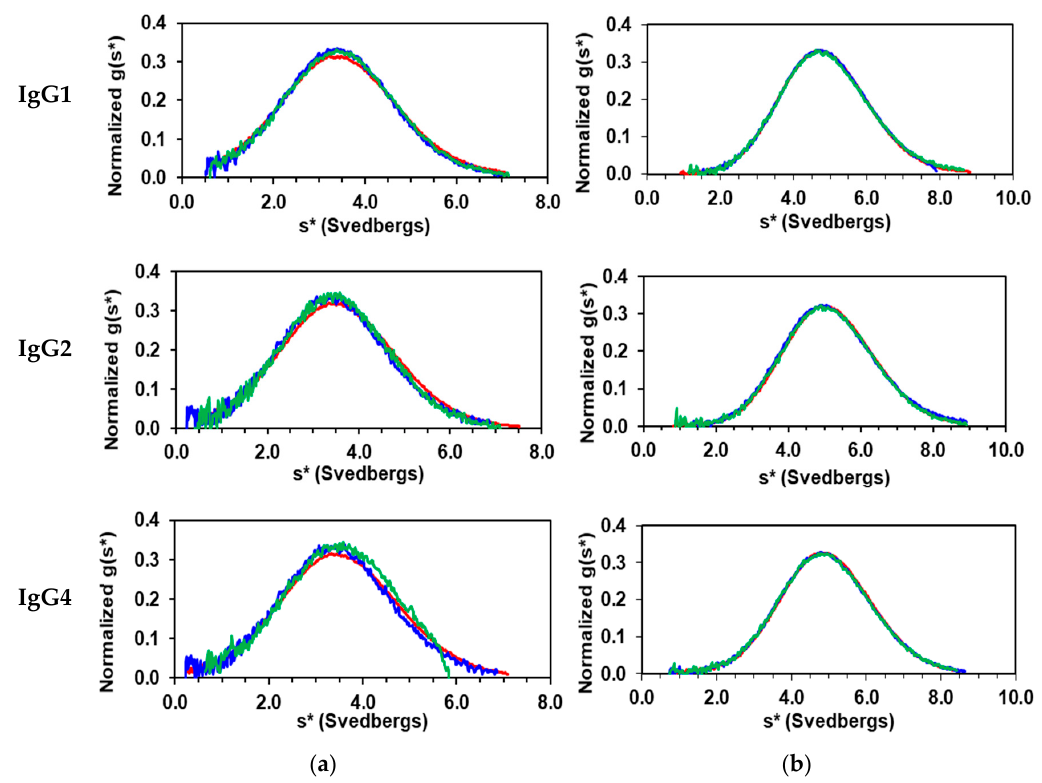
Figure 2. Sedimentation velocity analysis of IgG1, IgG2, and IgG4 cleaved ( a ) Fc and ( b ) F(ab’) 2 from mAb 1 in pH 5.0 acetate. Normalized g(s*) sedimentation distributions obtained with the concentration of 0.5 mg/mL (red), 0.167 mg/mL (blue), and 0.056 mg/mL (green). The graph for IgG4Pro F(ab)’ 2 is not shown because it is indistinguishable from IgG4. Refer to text for the s w values.